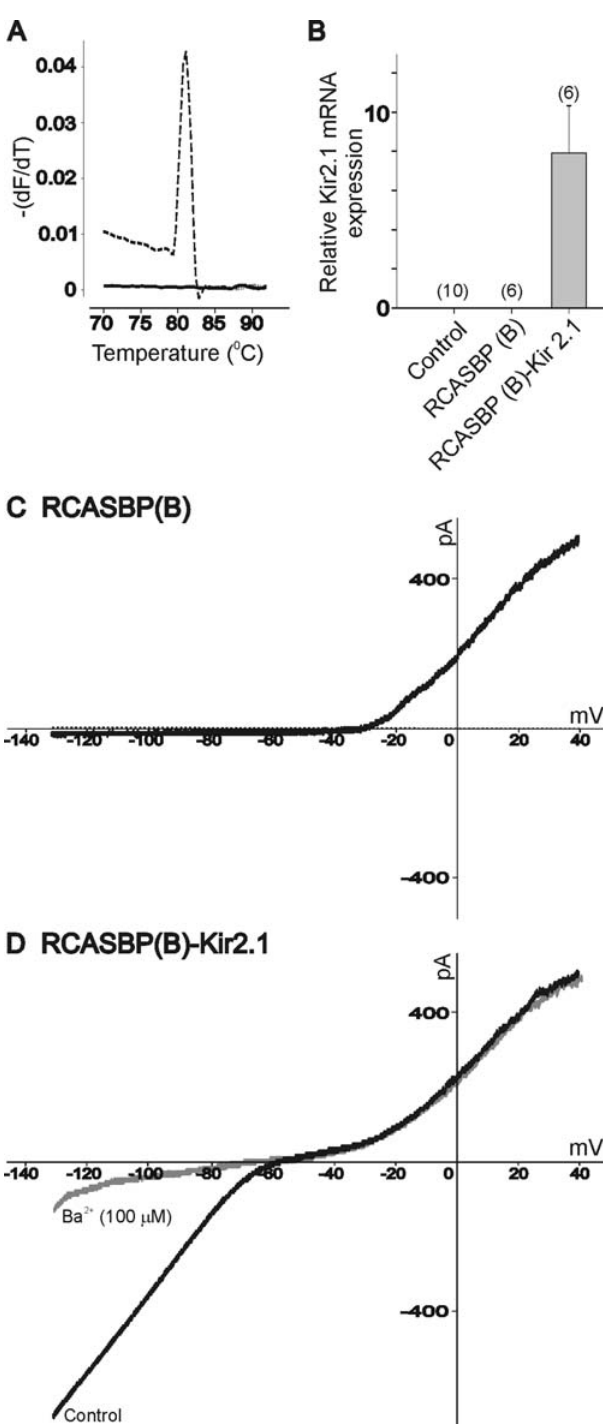
Figure 4. Kir2.1 expression in the chicken spinal cord. A) Typical melting curve from samples obtained from an RCASBP(B)-infected embryo (continuous line) or an RCASBP(B)-Kir2.1-infected embryo (discontinuous line). Fluorescence melting peaks were obtained by plotting the negative derivative of the fluorescence signal over temperature (-dF/dT) as a function of temperature (T). Notice the sharp peak in the sample obtained from an RCASBP(B)-Kir2.1- but not RCASBP(B)-infected embryo, indicating the presence of one PCR product. B) Quantification of Kir2.1 mRNA expression by real time PCR in chicken ventral spinal cords isolated at E8. C&D) Whole cell recordings from RCASBP(B) and RCASBP(B)-Kir2.1 infected